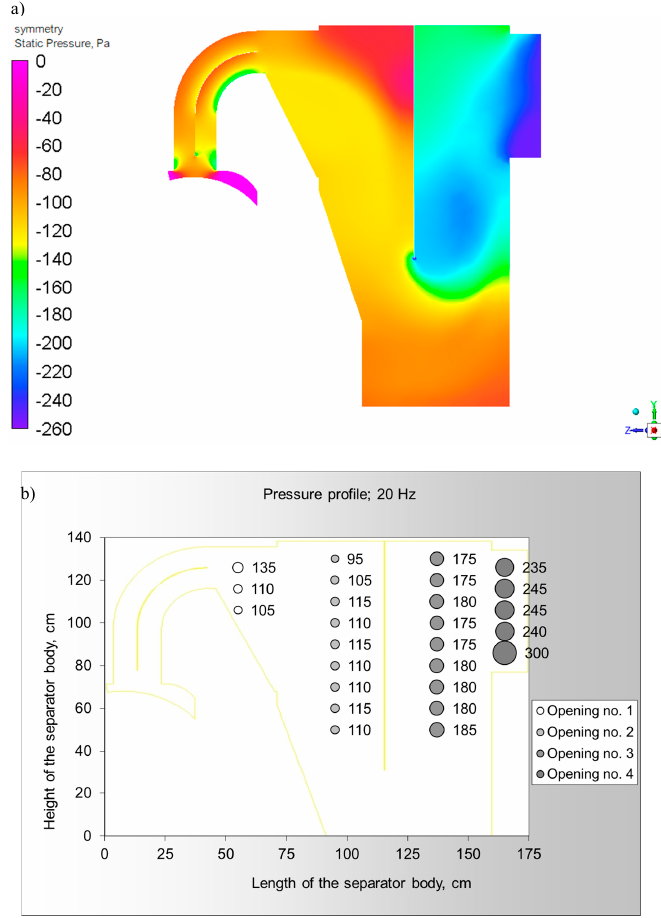
Figure A10. Pressure profile in the sorter symmetry plane (simulation of the main fan at 20 Hz): ( a ) numerical model (gauge pressure) and ( b ) measured (negative pressure).